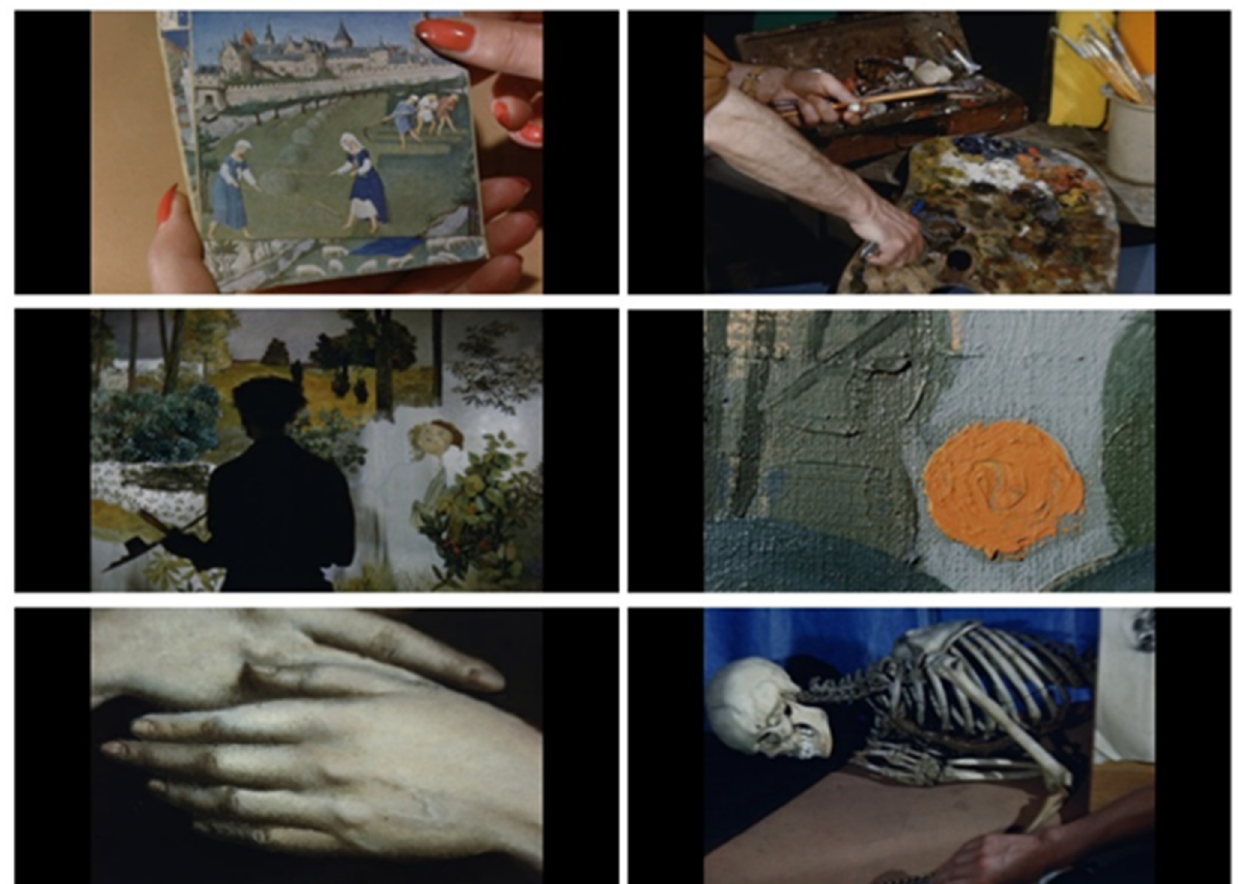
Figure 4. Paul Haesaerts, Quatre peintres belges au travail , 1952 (digital film frames). From left to right, these panels illustrate: Images of Les Très Riches Heures du duc de Berry (the Limbourg brothers, c. 1415); the painting palette of Albert Dasnoy; the back-side of the Dasnoy’s painting of youth and summer in progress; a close-up of a painting by Jean Brusselmans; a close-up of a painting by Paul Delvaux; and Paul Delvaux’s skeleton as a model for his painting on death and winter.